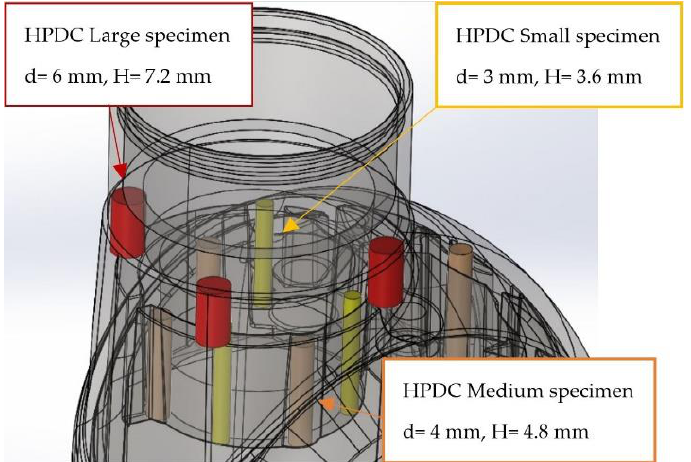
Figure 2. Cylindrical specimens of different diameters (3, 4, 6 mm) shown in a transparent 3D-model of the casting (HPDC- high-pressure die casting).